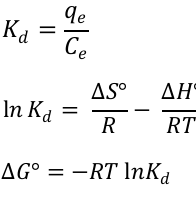
O (  ) and Fe O /C ( • ) at 298 K 3 4 3 4 O (a) and Fe O /C (b) at 298 3 4 3 4